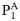
Two-cycle exchange.
P1A blood type is incompatible with his donor D1B, the incompatibility is represented by dotted lines. The two incompatible pairs can swap their kidneys as illustrated by solid lines.